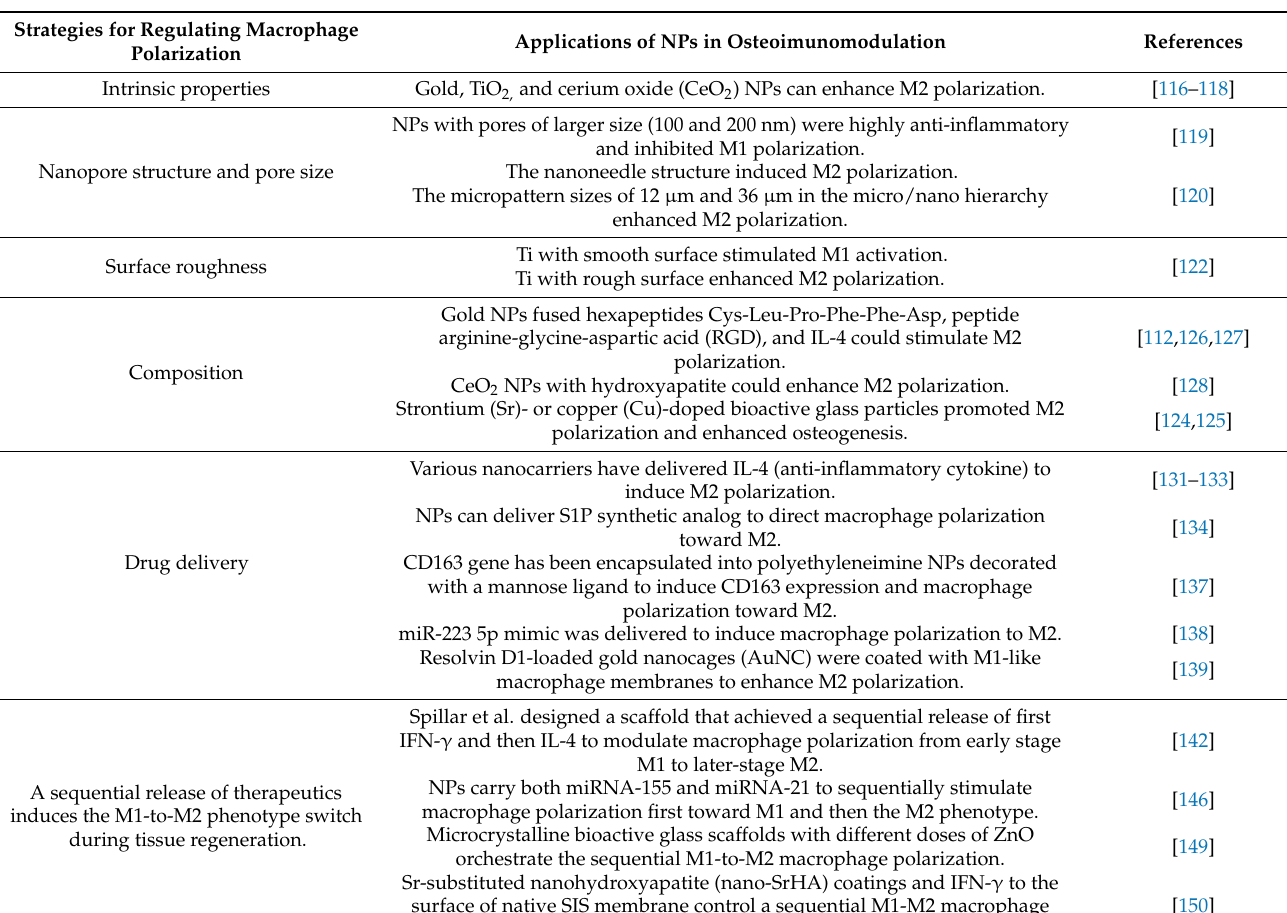
Table 2. Applications of NPs in osteoimunomodulation via modulating macrophage response. Strategies for Regulating Macrophage